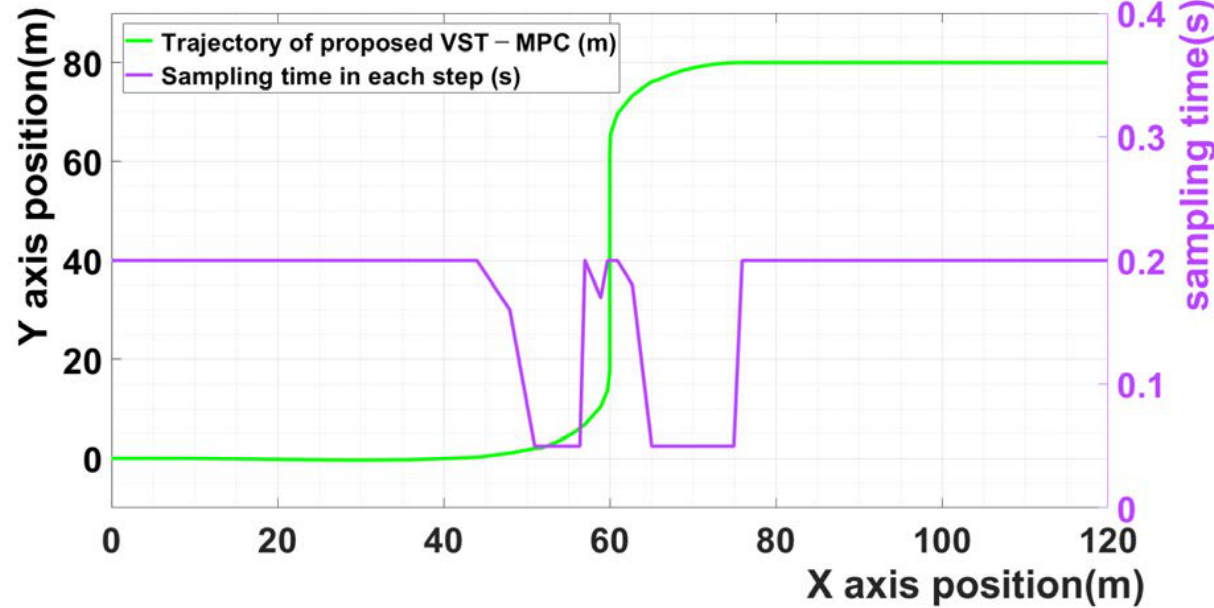
Figure 3. The sampling time of scenario 1 in each step.